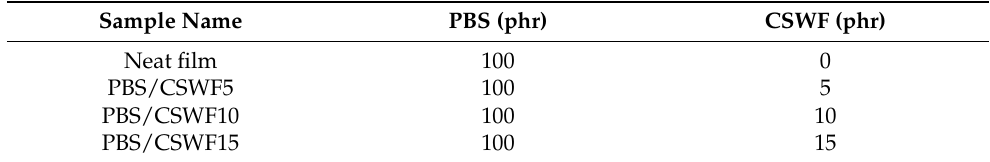
Table 1. Compositions of the composite